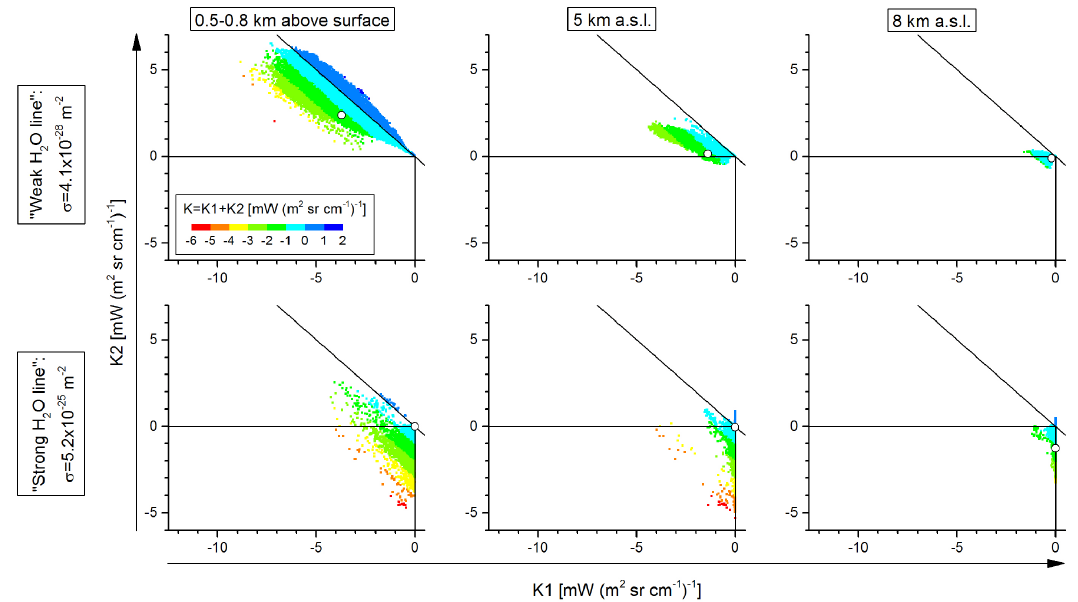
Figure 2. H 2 O Jacobians calculated according to Eqs. (2)–(4) for two different line strength and three different altitudes. Plotted is K 1 i,j versus K 2 i,j (the colour code informs about K i,j = K 1 i,j + K 2 i,j ). The upper panels represent a weak and a strong line, respectively. The left panels are for the boundary layer (about 500 to 800m above surface), the middle panels for 5kma.s.l., and the right panels for 8kma.s.l. The black circles filled by white colour indicate the results obtained for the surface and atmospheric conditions corresponding to the averaging kernels of Fig. 1.